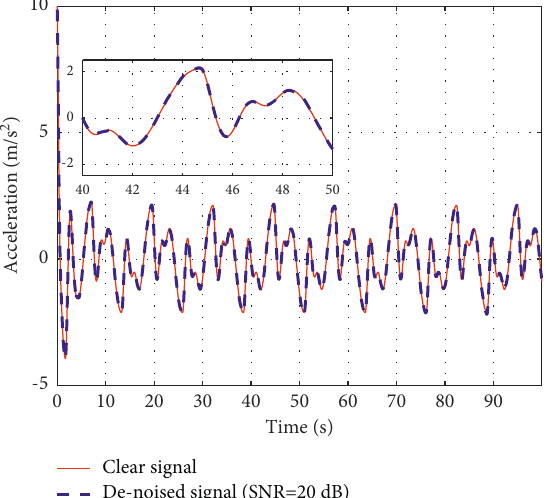
Figure 13: Noise elimination of non-linear signal using proposed method when SNR � 50